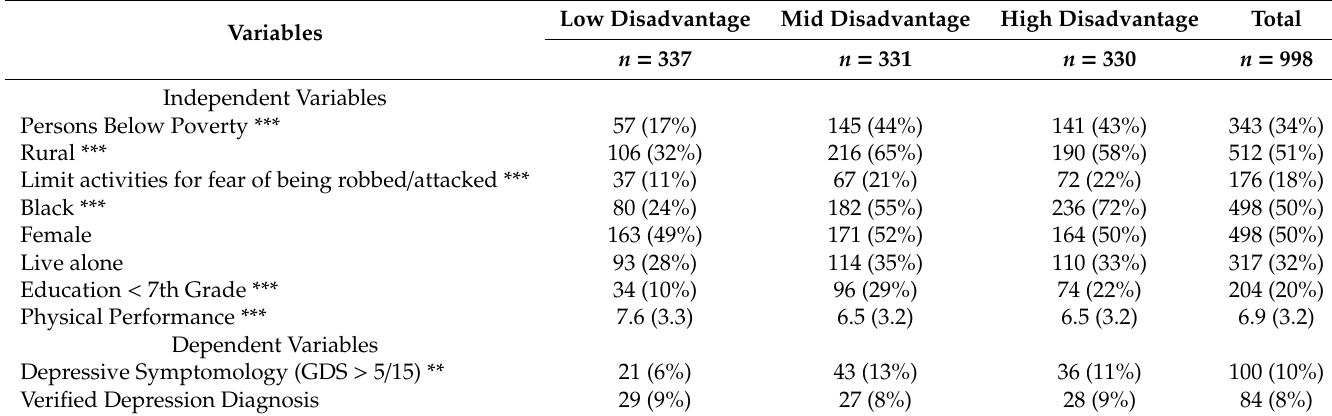
Table 1. Participant and neighborhood characteristics by level of neighborhood disadvantage.